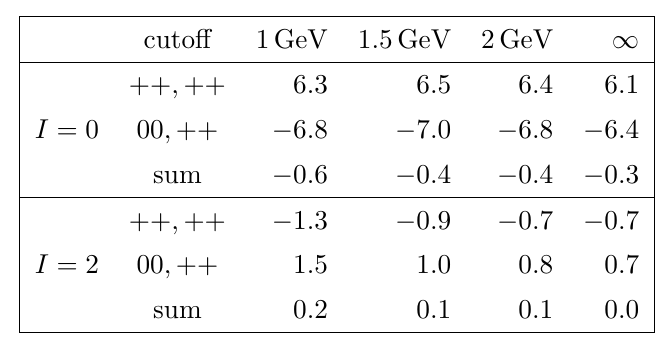
Table 4. Contribution to the sum rule (2.91) from h 0 integrated over momenta and virtualities in the ( g text, in units of 10 (cid:0) 11